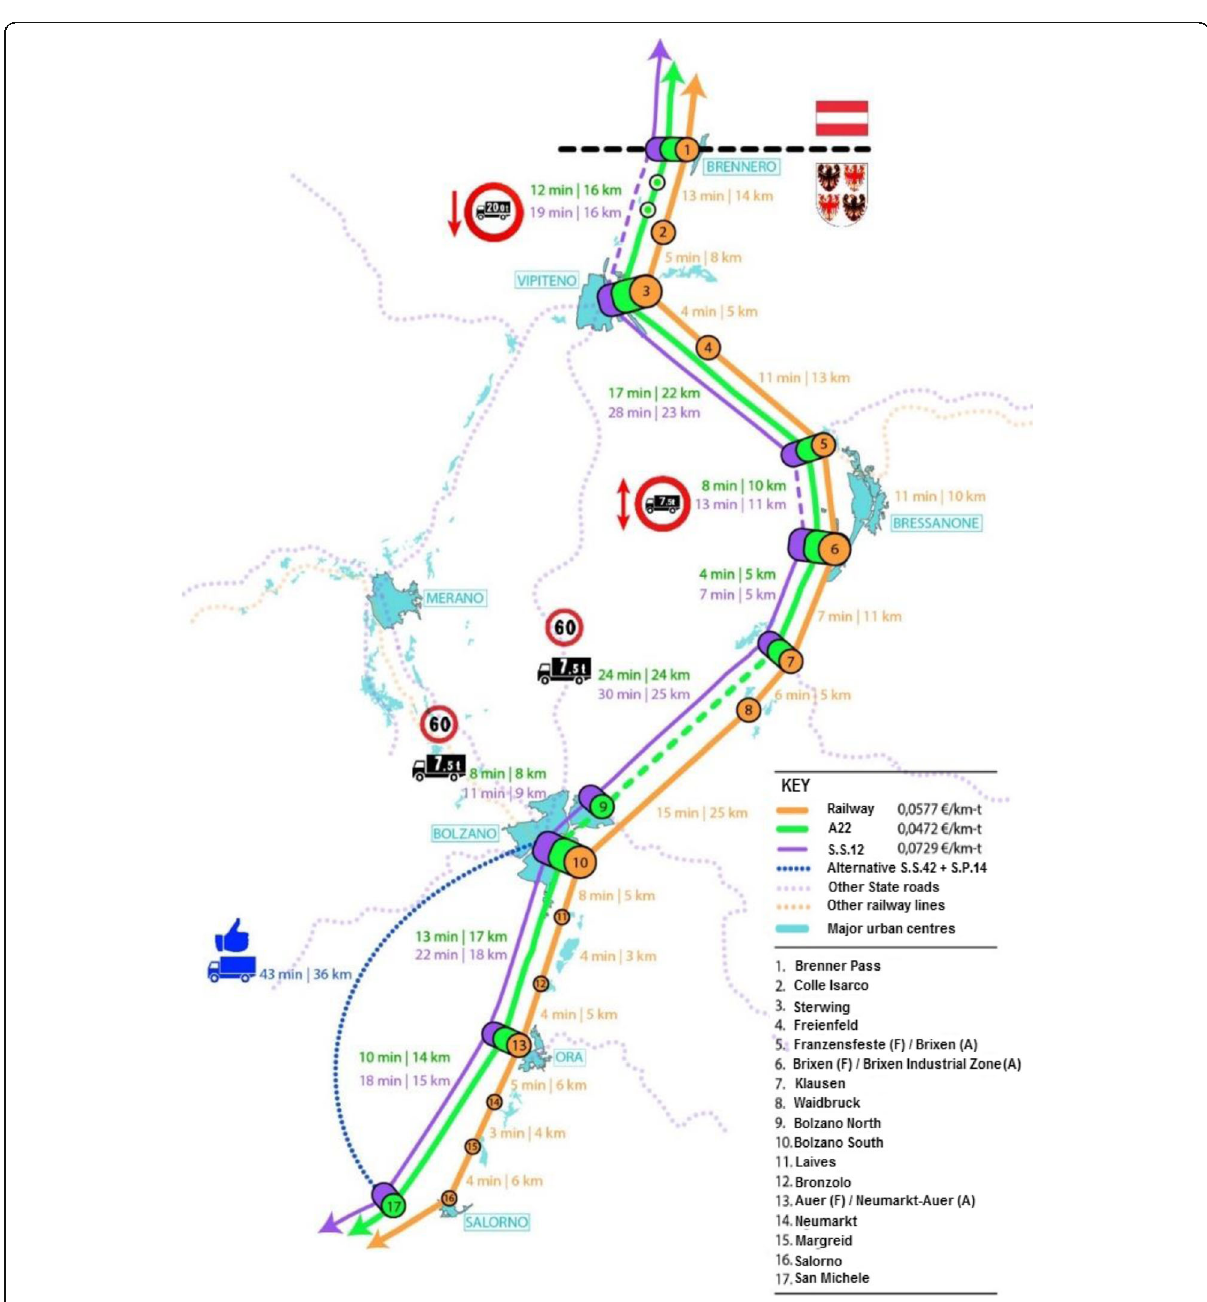
Fig. 1 The Brenner corridor: transport infrastructures in South Tyrol and costs for